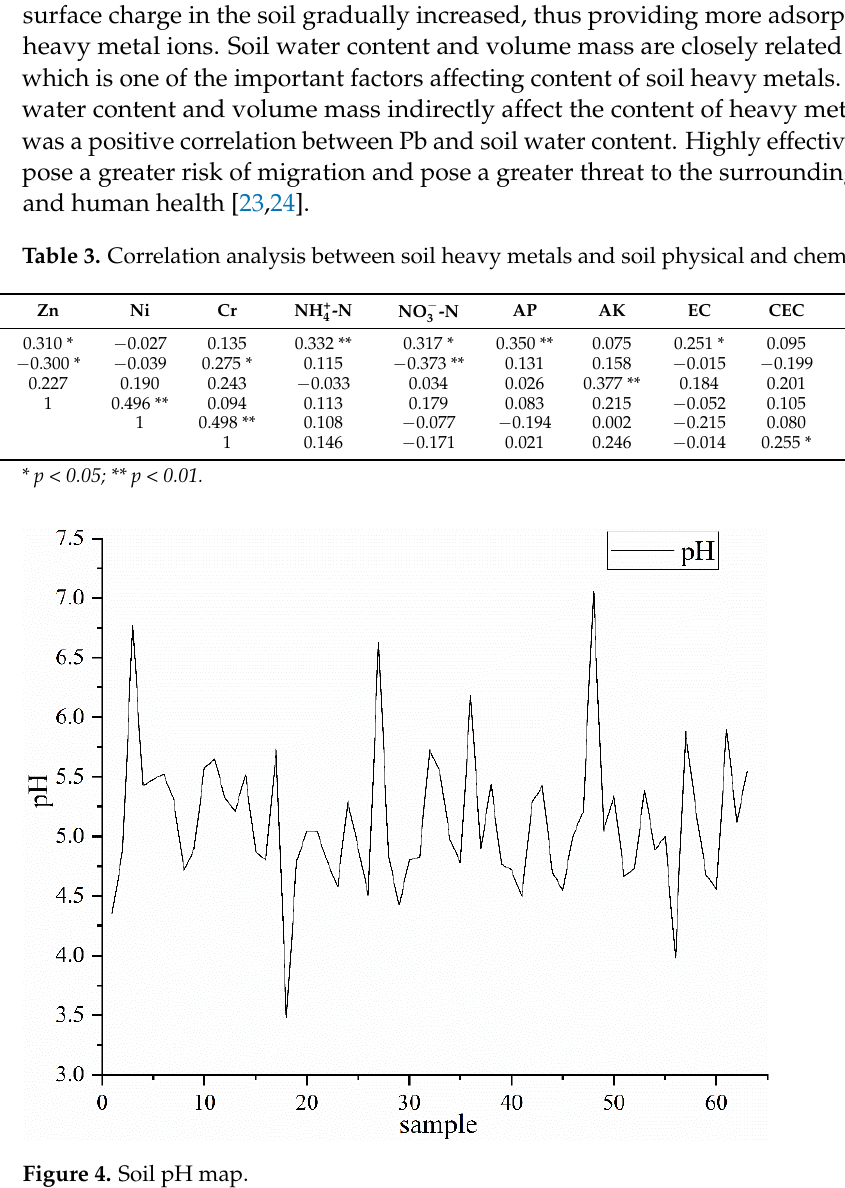
Figure 4. soil pH map. Figure 4. Soil pH